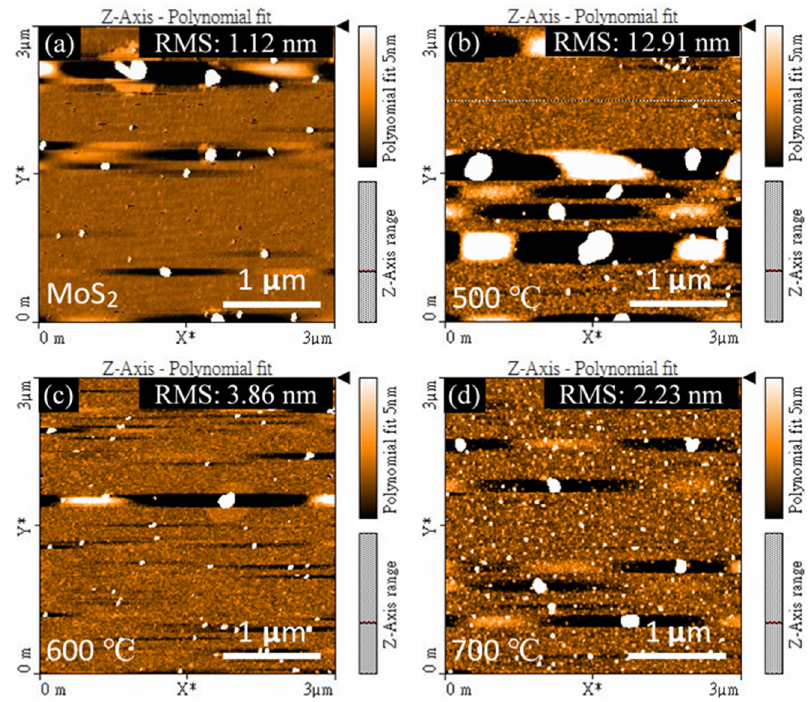
Figure 2. AFM images and RMS values of ( a ) substrate: 2D MoS 2 on c-sapphire, ( b ) T1: GaN films grown on MoS 2 at 500 °C, ( c ) T2: GaN films grown on MoS 2 at 600 °C and ( d ) T3: GaN films grown on MoS 2 at 700 °C.